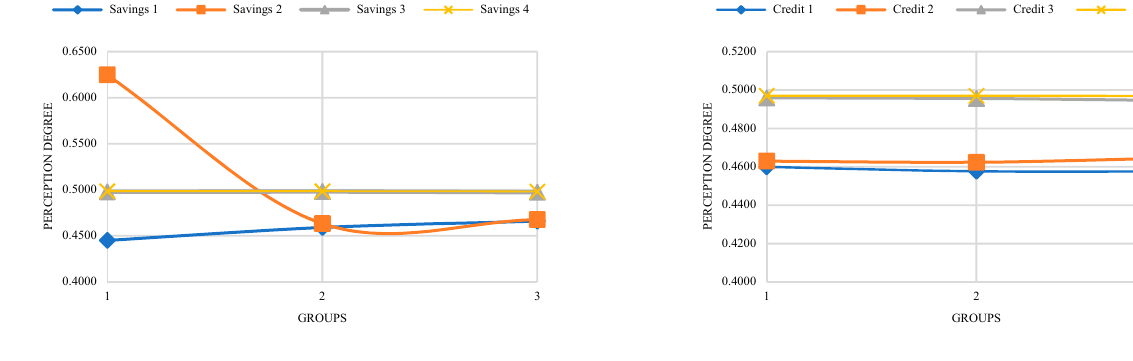
Figure 3. Perception of savings and credit by group.